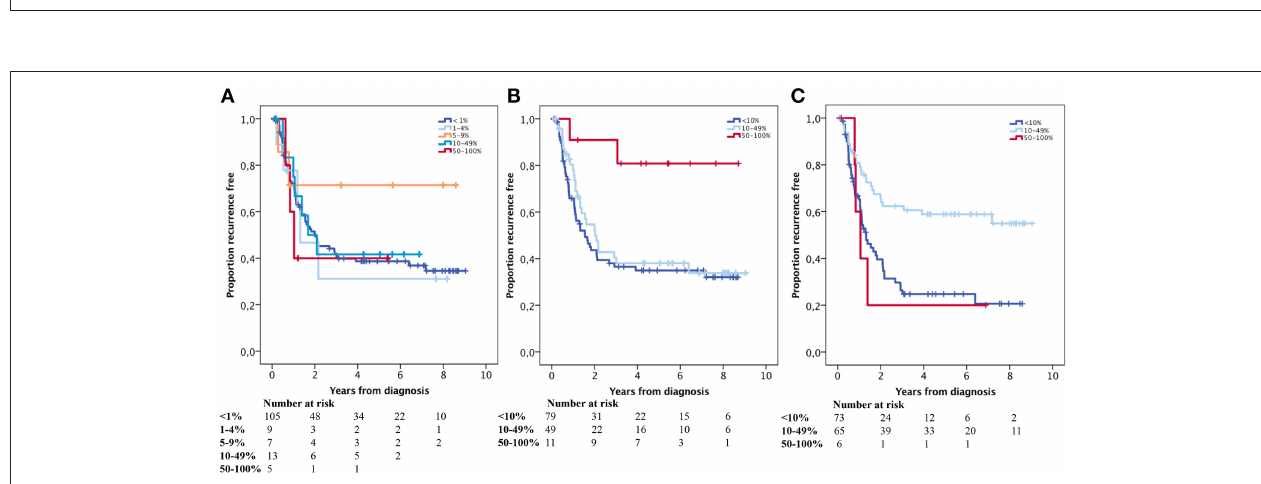
FIGURE 3 | Kaplan-Meier analysis of OS in strata according to immunohistochemical staining categories of (A) PD-L1 expression on, (B) PD-L1 expression on, and (C) PD-1 expression on in the entire cohort. (A) < 1% = ref, 1–4% p = 0.285, 5–9% p = 0.815, 10–49% p = 0.721, 50–100% p = 0.763, (B) < 10% = ref, 10–49% p = 0.512, 50–100% p = 0.014, (C) < 10% = ref, 10–49% p = 0.003, 50–100% p = 0.842.